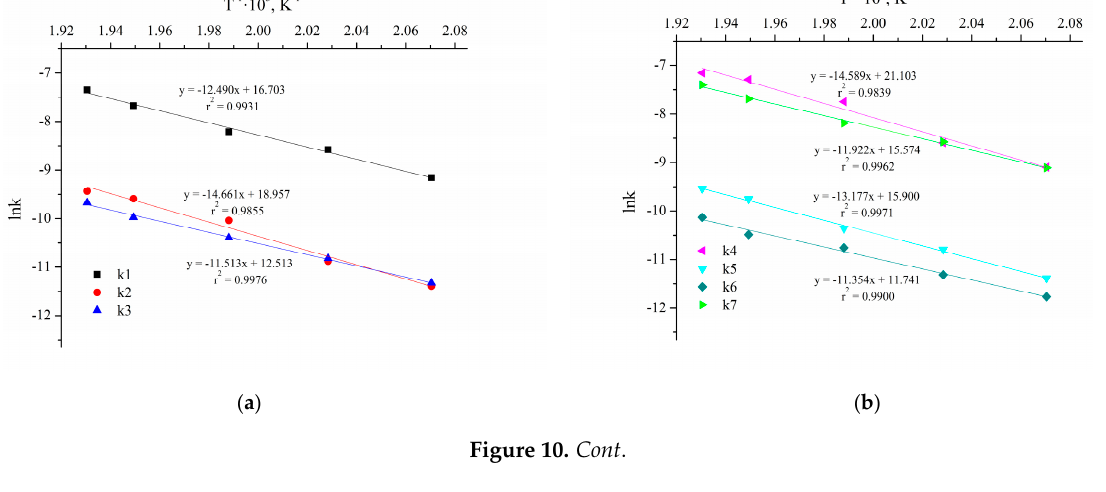
Figure 10. Cont . Catalysts 2019 , 9 , x FOR PEER REVIEW